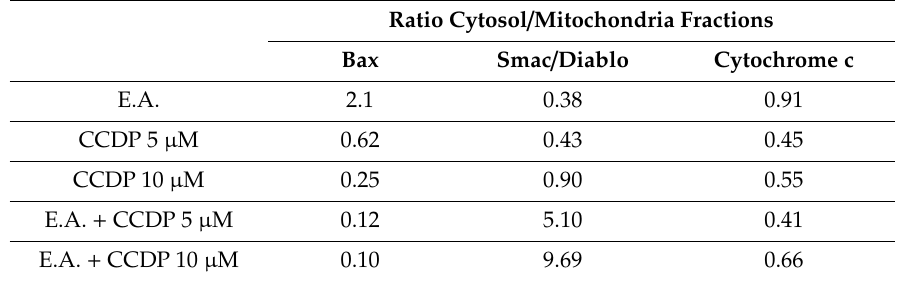
Table 3. Ratio of cytosol / mitochondria fractions after treatment on the 4T1 breast cancer cells. Ratio Cytosol / Mitochondria Fractions Bax Smac / Diablo Cytochrome c